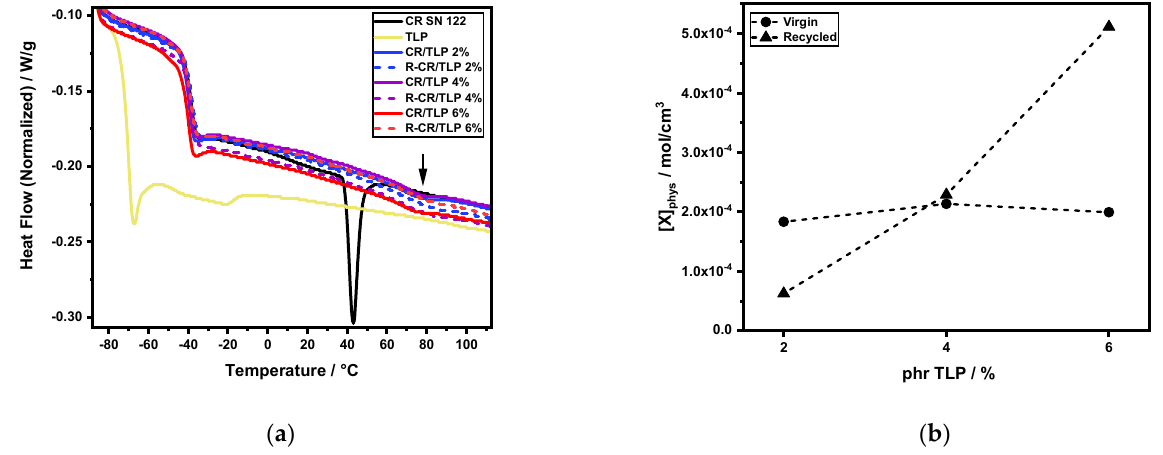
Figure 4. Properties comparison between CR SN 122, TLP, cured compounds and recycled compounds: ( a ) dynamic DSC heating traces showing slight shift of T g of cured compounds and recycled compounds, CR SN 122 and TLP, and different T c ; ( b ) cross-link density comparison between cured compounds and recycled compounds.